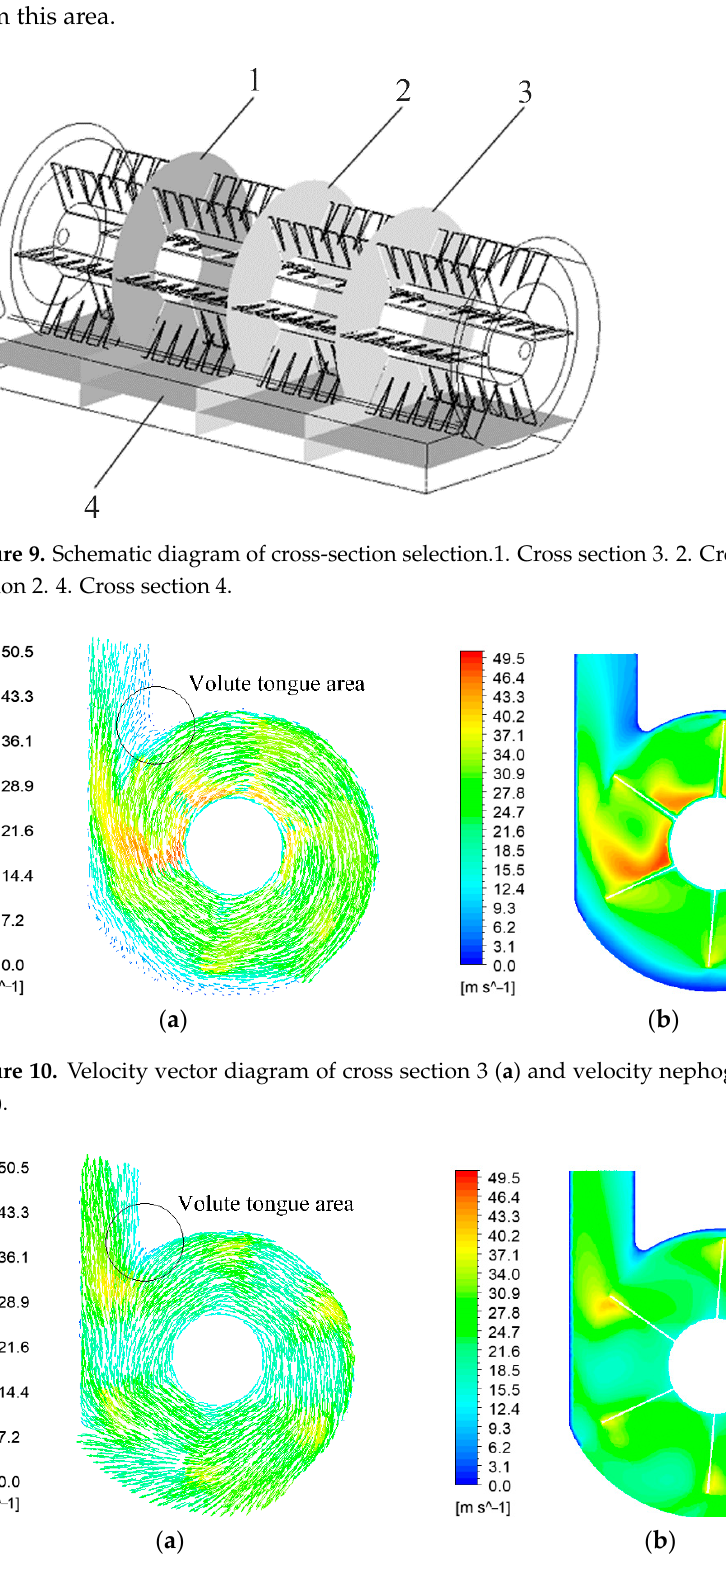
( b ) Figure 12. Velocity vector diagram of cross section 2 ( a ) and velocity nephogram of cross section 2 ( b ). Moreover, in Figure 13, the maximum velocity is 28.06 m/s, and the average velocity is 12.34 m/s. It is known that there is a small amount of cotton stalks on the surface of residual film, and the suspension velocities of residual film and cotton stalks are